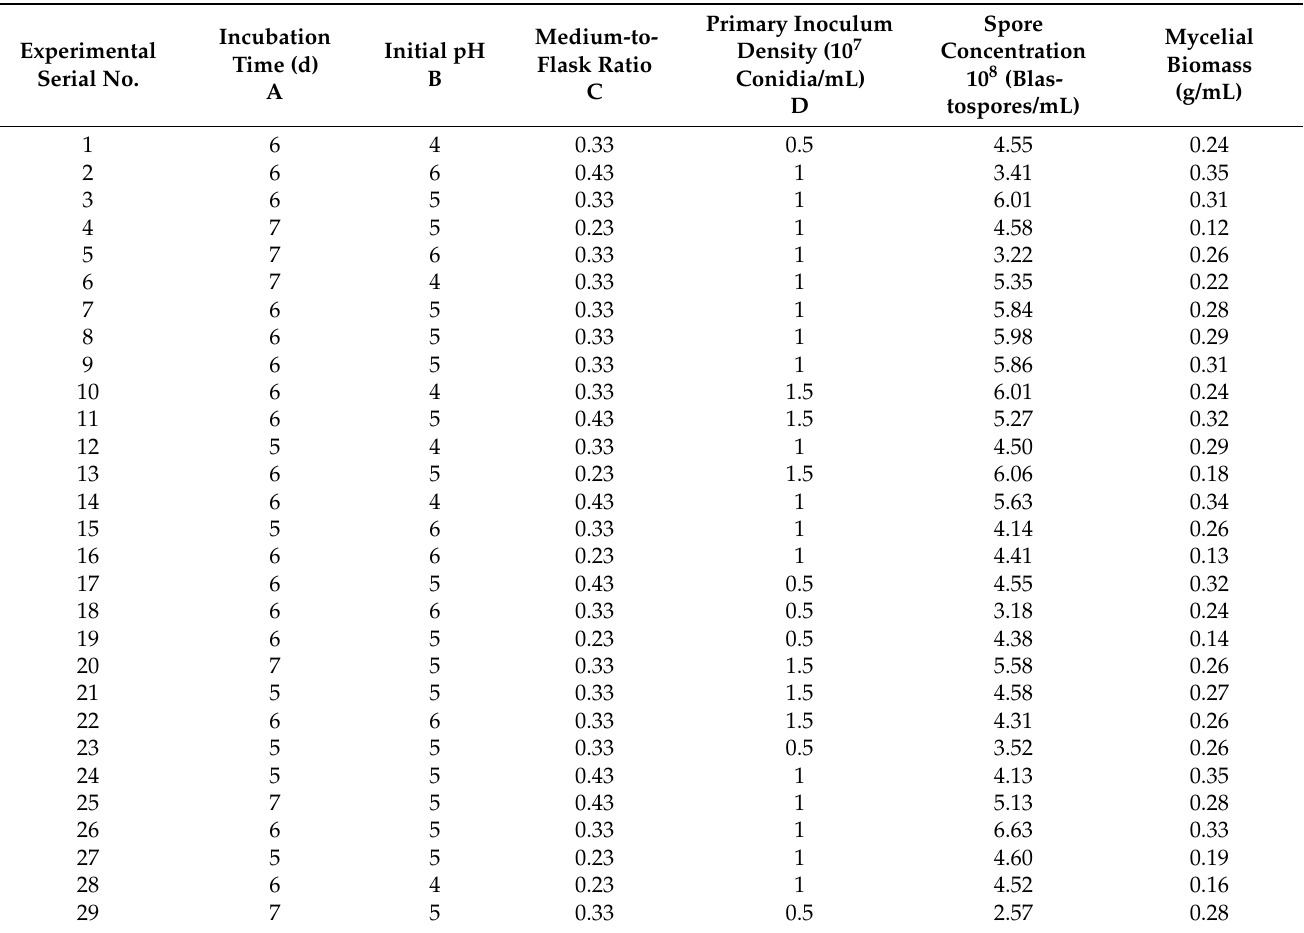
Table 3. BBD and the experimental